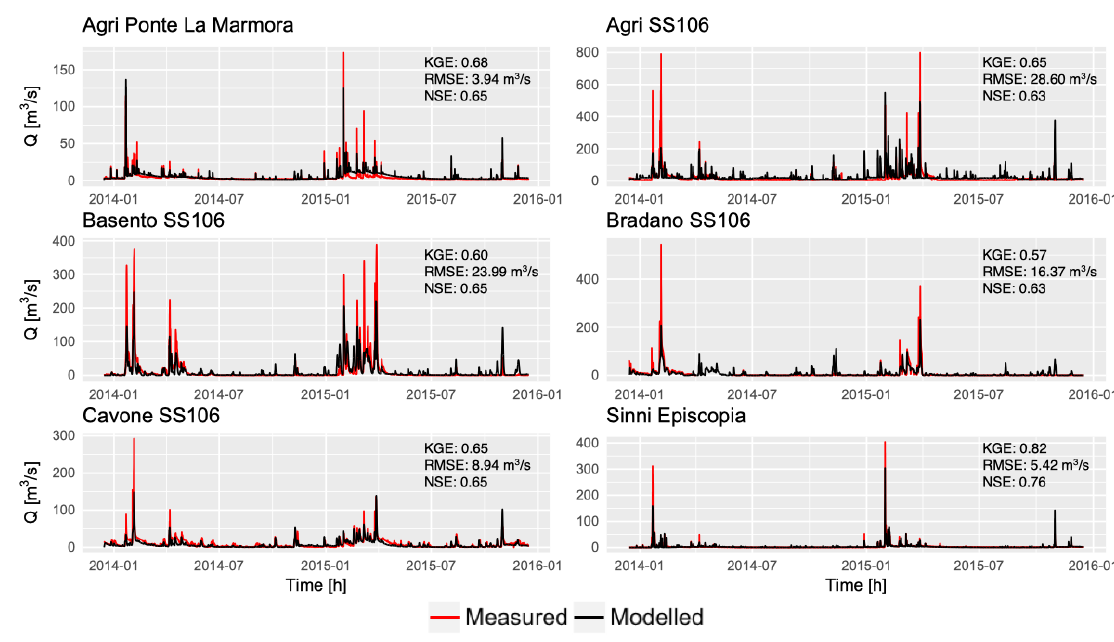
Figure 7. Idrograph obtained for each of the six investigated points: red lines represent measured discharges, while black lines represent simulated